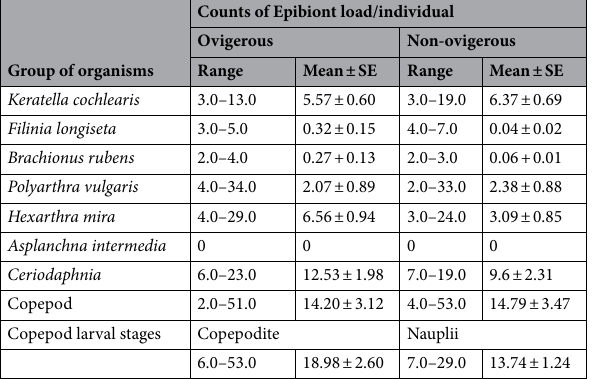
Table 2. Epibiont loads (No. of individuals) on ovigerous and non-ovigerous rotifers and adults and larval stages of